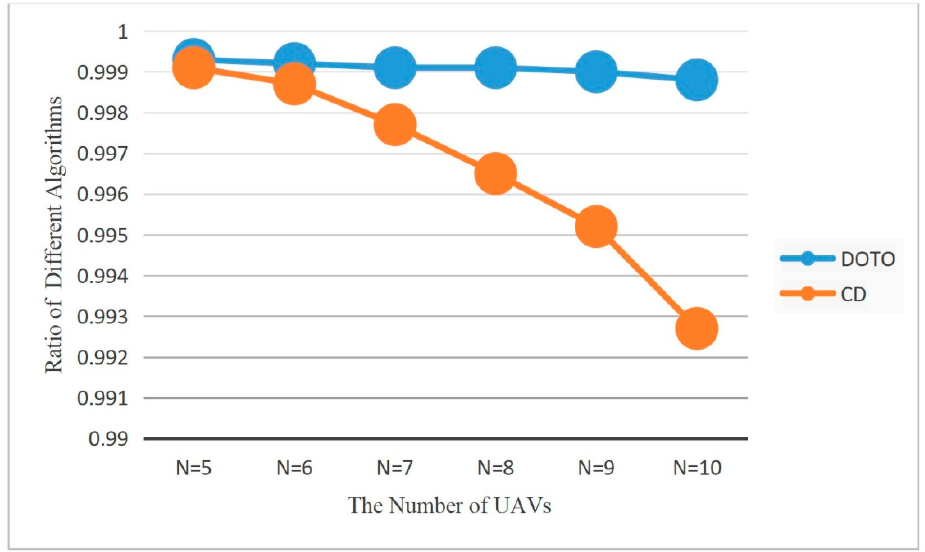
Figure 4. The ratio of the results of the DOTO algorithm and the CD algorithm to the results of the optimal offloading decision.